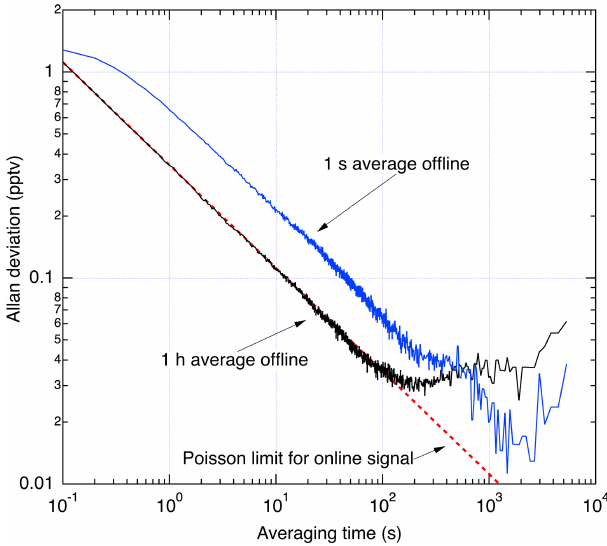
Figure 12. Allan deviation analysis from 1.4h of sampling scrubbed zero air in the